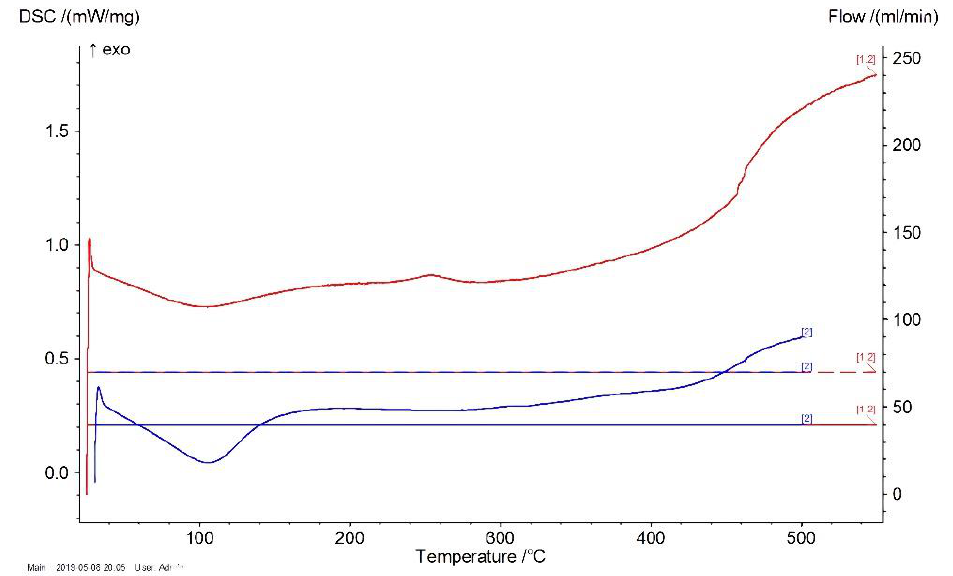
Figure 4. The DSC curves of the varnish/xylene: 1/1 film (red) and the varnish/xylene/KPT-8 filler: 10/10/1 composition (blue).